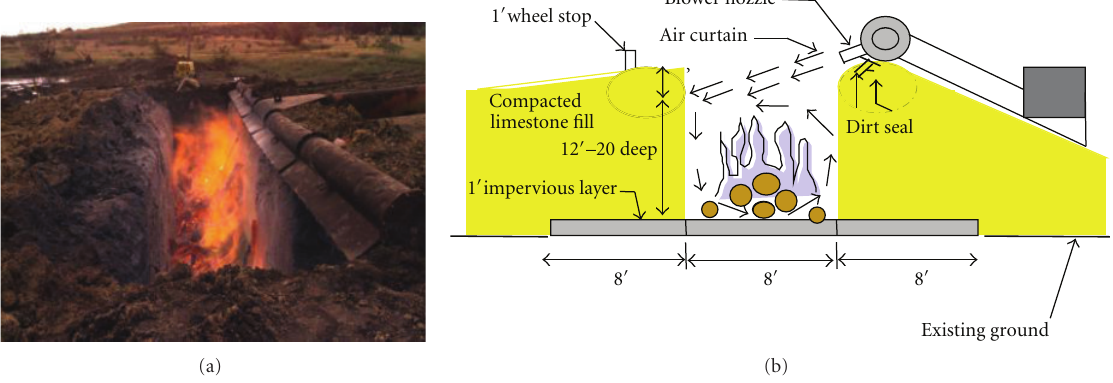
Figure 3: Below-grade air curtain incineration.